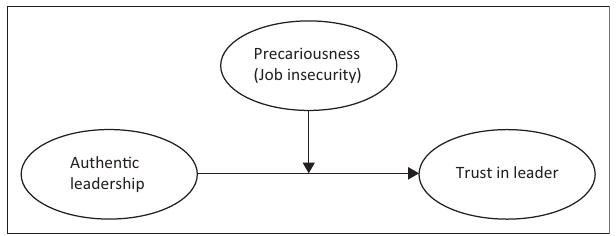
FIGURE 1 : The research